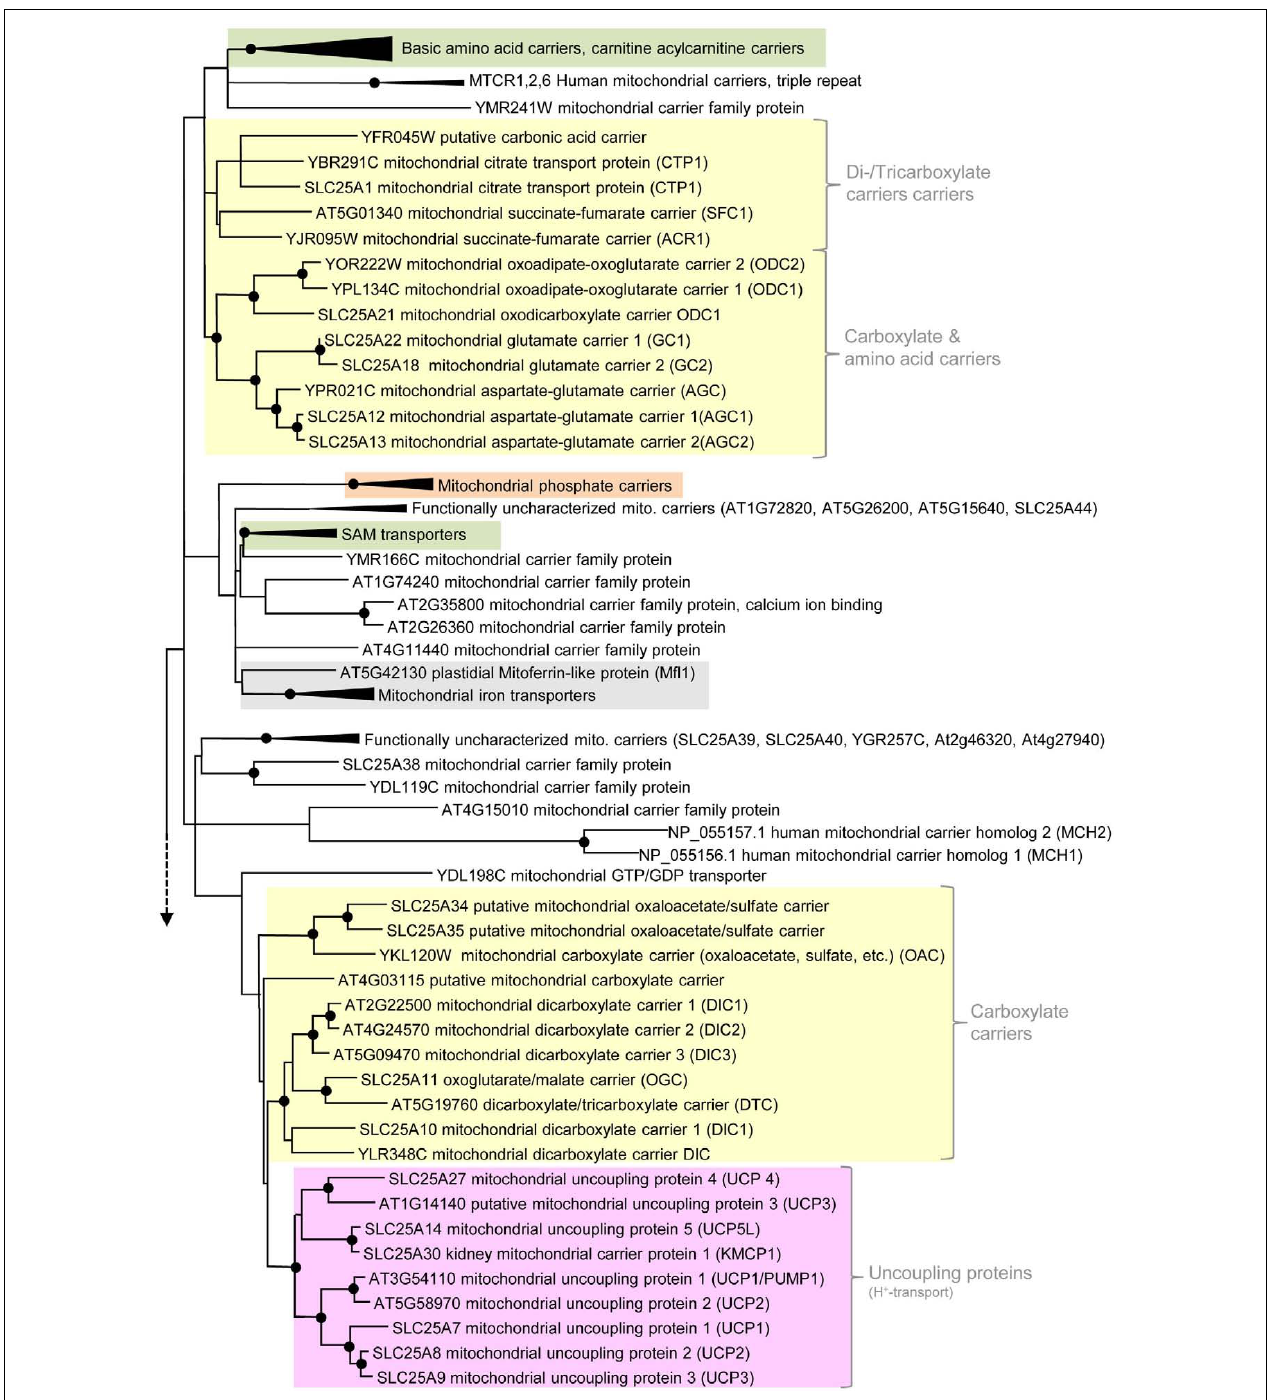
Nodes that are supported by bootstrap values (maximum likelihood and maximum parsimony, 1000 replications) higher than 70 are indicated by black